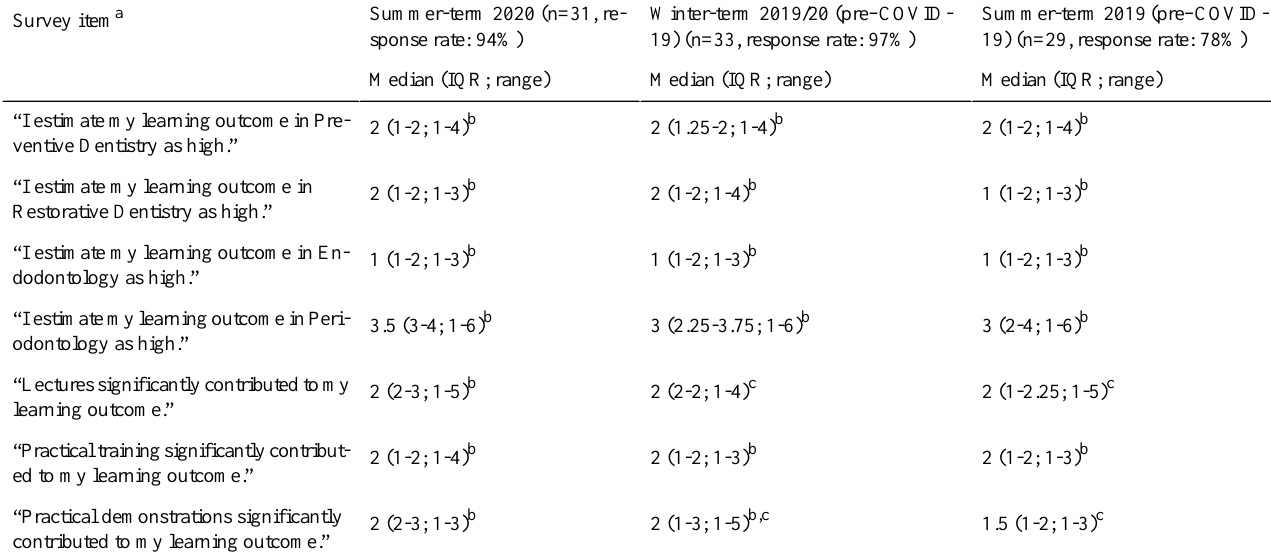
Table 3. Students’self-assessment of learning outcome during summer-term 2020 and the pre–COVID-19 terms.